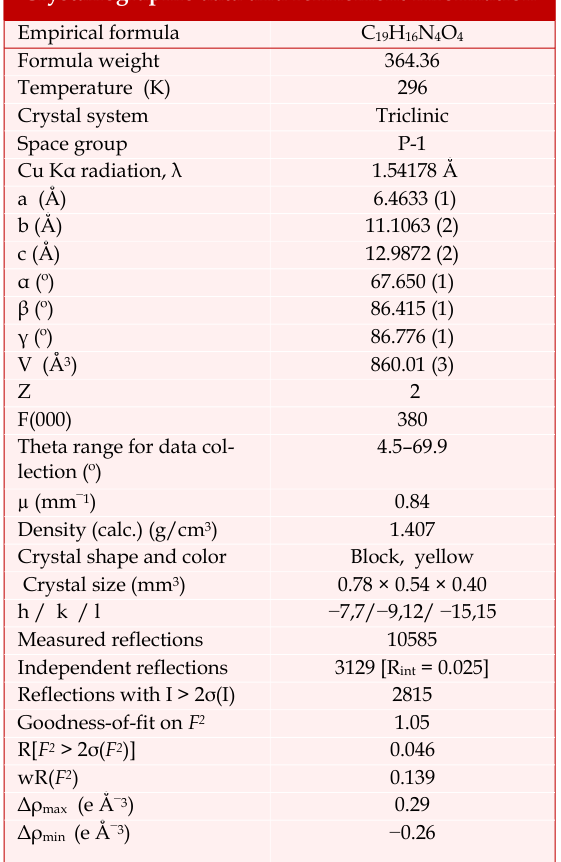
Crystallographic data and refinement information Empirical